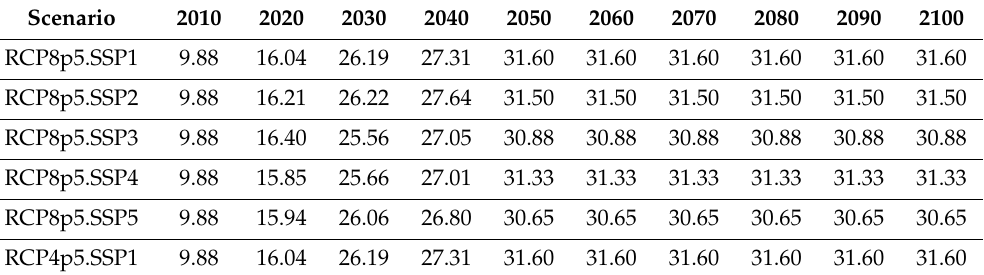
Table A5. Harvest of forest residues (millions of m 3 /